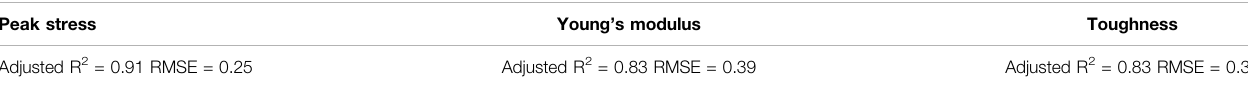
TABLE 2 | Goodness-of- fi t of the mixed effects models used to analyze the mechanical parameters. Peak stress Young ’ s modulus